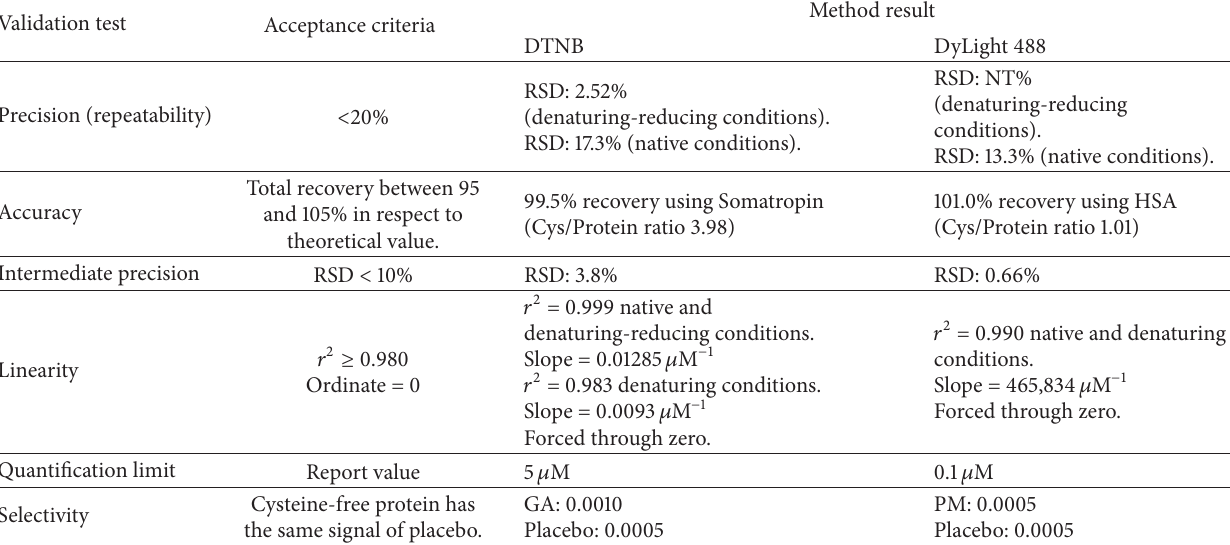
Table 1: Validation results for DTNB and DLM